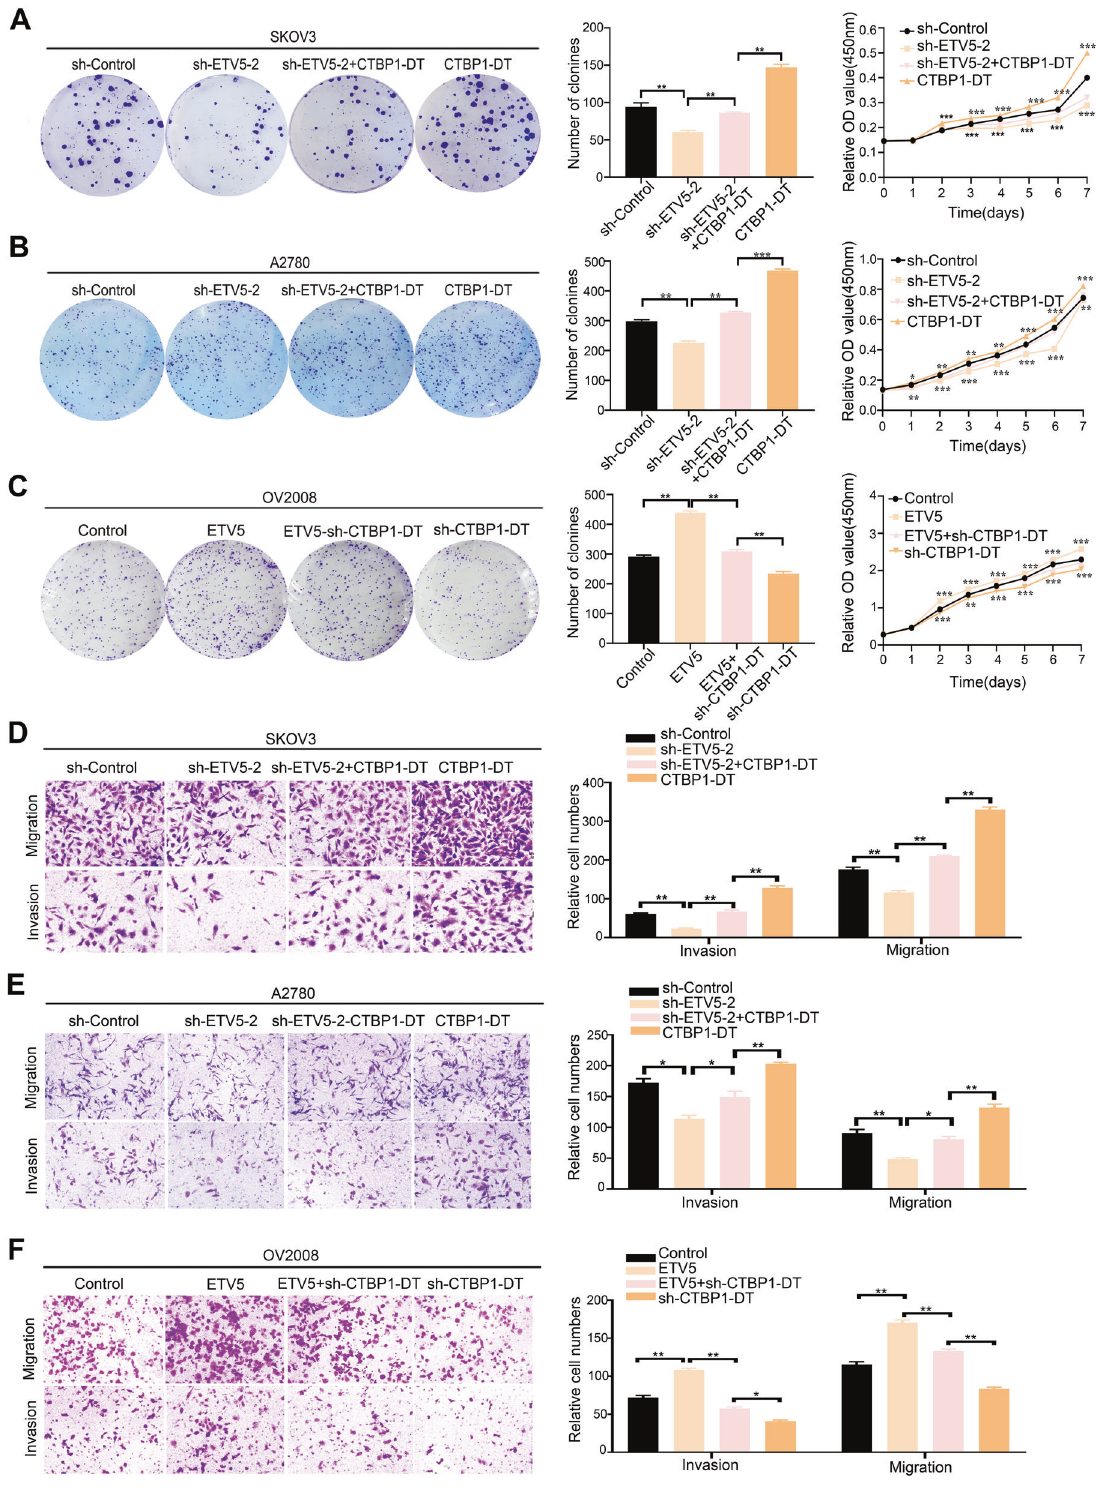
Fig. 6 ETV5 enhances HGSOC cell proliferation, migration and invasion through lncRNA CTBP1-DT. A , B Cells were transfected with indicated sh-Control, sh-ETV5-2, sh-ETV5-2 with CTBP1-DT and CTBP1-DT, respectively. CCK-8 and colony formation assays were used to determine the proliferation of SKOV3 or A2780. C Cells were transfected with indicated Control, ETV5, ETV5 with sh-CTBP1-DT and sh-CTBP1- DT, respectively. Proliferation of OV2008 was detected by CCK-8 and colony formation assays. D , E After transfected with sh-Control, sh-ETV5- 2, sh-ETV5-2 with CTBP1-DT and CTBP1-DT, transwell migration and invasion assays were performed in SKOV3 and A2780, respectively. F After transfected with Control, ETV5, ETV5 with sh-CTBP1-DT and sh-CTBP1-DT, transwell migration and invasion assays were performed in OV2008, respectively. Data are presented as the mean ± SEM. * P < 0.05, ** P < 0.01, *** P < 0.001.